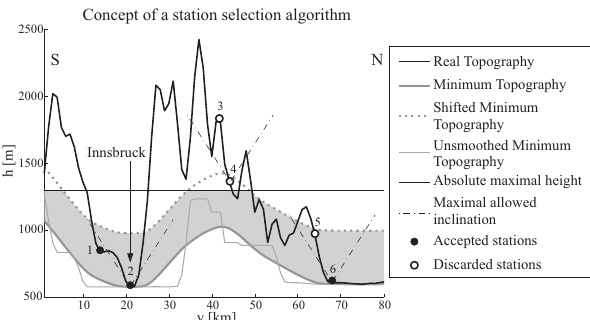
Fig. 2. Concept of the station selection algorithm on the basis of a north–south cross section through the mountains near Innsbruck (compare Fig. 1a). The reasons for accepting stations (compare sta- tions 1, 2 and 6) or for discarding stations (compare stations 3, 4 and 5) are explained in the text. Note that the absolute maximal height was set to h =1300m (instead of h =1500m) and the ratio r to r =50mkm − 1 (instead of r =15mkm − 1 ) in order to create an example containing all three criteria for excluding a